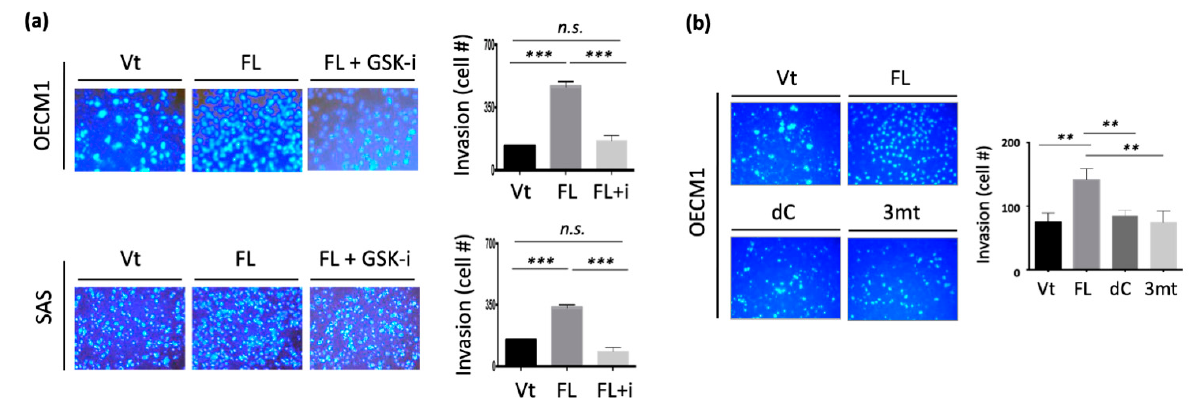
Figure 7. The phosphorylation of 3R-motif by GSK3b is critical for cell motility in HNC cells. ( a ) Dephosphorylation of NDRG1 by GSK3b inhibitor reversed the effect of NDRG1-induced cell invasion. The HNC cells (OECM1, SAS) were transfected with NDRG1-FL or the vector plasmids, with or without the addition of GSK3b inhibitors (SB21673, 3 μ M) for 24 h. These cells were then subjected to Matrigel invasion assay. ( b ) Mutation of GSK3b phosphorylation sites in NDRG1-3R motif reversed the effect of NDRG1-induced cell invasion. After transfection of various NDRG1 truncated plasmids (-FL, -dC, -3mt) into OECM1 cells for 30 h, these cells were subject to Matrigel invasion assay. All the experiments were performed three times independently and typical results were shown. The error bars shown in the relevant figures indicate the standard deviation of the quantification results in all experiments. (** p < 0.01; *** p < 0.001; n.s., no significance; t -test). 3.8. NDRG1 Is Overexpressed in Tumors and Is Associated with Poor Prognosis in Patients with HNC